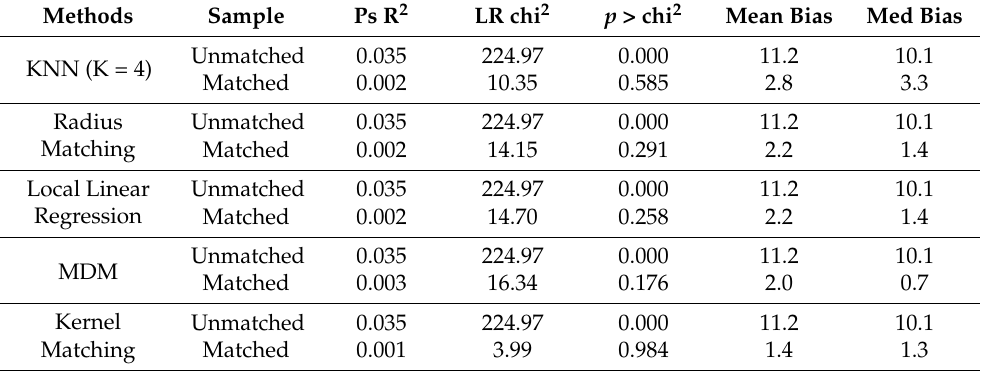
Table 10. Balancing